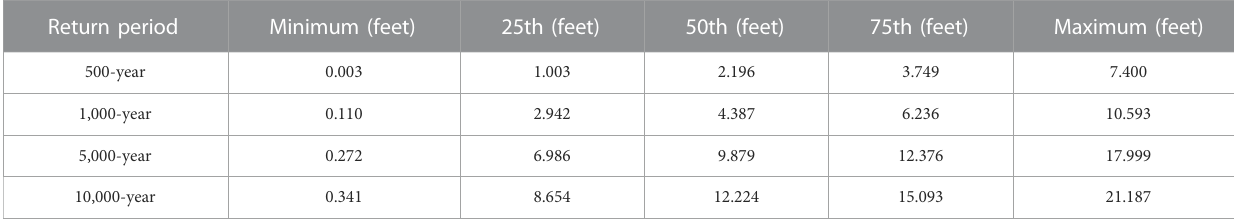
TABLE 2 Descriptive statistics of fl ood depth at long return periods using synthetic data in the shaded X Zone. Return period Minimum